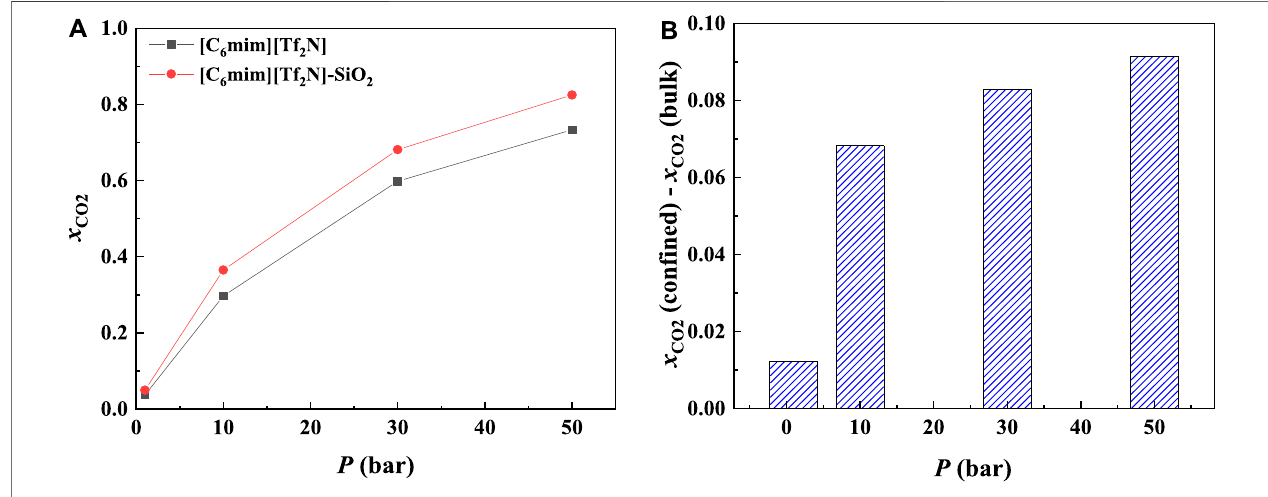
FIGURE 8 | Calculated CO 2 solubility (A) and additional solubilities (B) of con fi ned ILs in 25 Å slit-shaped pore at 298.15 K and different pressures.